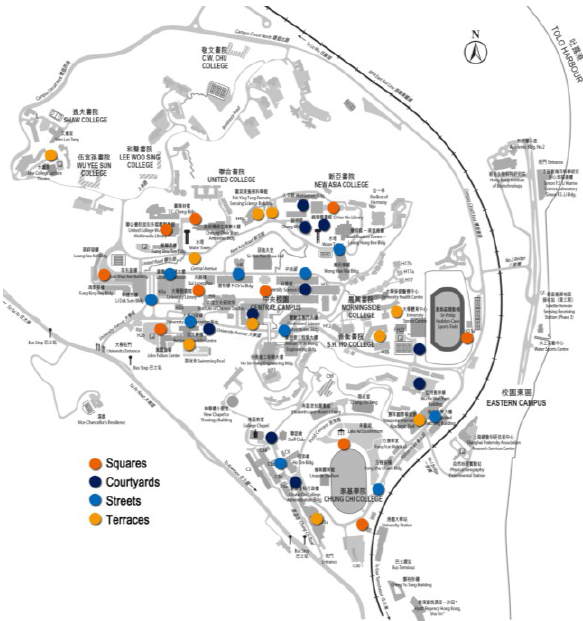
Figure 4. Experimental Sites Distribution in CUHK